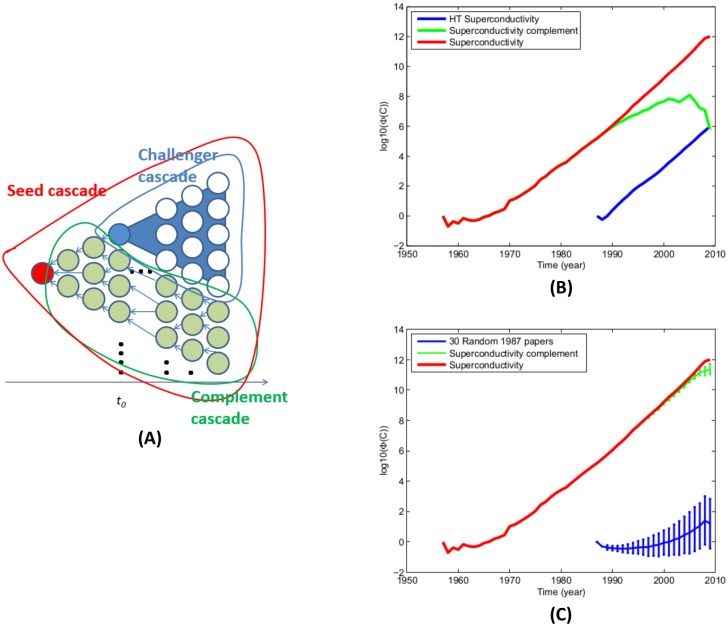
Disruption of the influence of the seed by a challenger can be observed in the changes to the citation cascade of the seed.(A) A citation cascade of a seed paper and residue cascade created by subtracting a challenger’s cascade. (B) An example of the disruption of the superconductivity theory (BCS) by the high temperature superconductivity theory (HTS). (C) 30 randomly selected papers published in the same year show no sign of cascade disruption to BCS, though the annual standard variation bars show that the growth of their own cascades are highly variant (blue curve). Meanwhile, the annual standard deviation bars of the growth of the residue cascades that they yield are small.